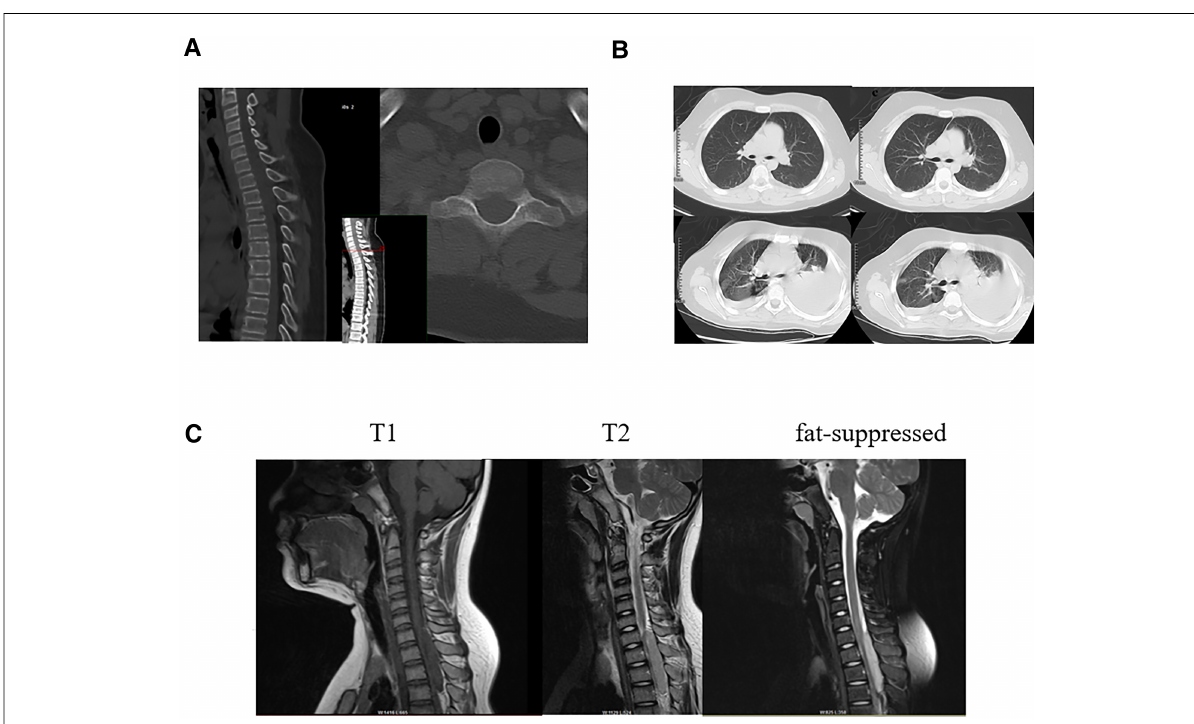
FIGURE 1 ( A ) Preoperative transverse and sagittal CT showed no bone destruction in the cervicothoracic junction. ( B ) Preoperative lung CT showed no obvious signs of tumor metastasis,Six months after the operation, lung CT showed multiple nodules in both lungs, and metastasis was considered. ( C ) T1- weighted, T2-weighted, and fat-suppressed sagittal MRI showed a long tubular mass in the spinal canal at the cervicothoracic junction, with a size of about 8 mm×15 mm×63 mm, and no abnormal signal vertebral body and appendage